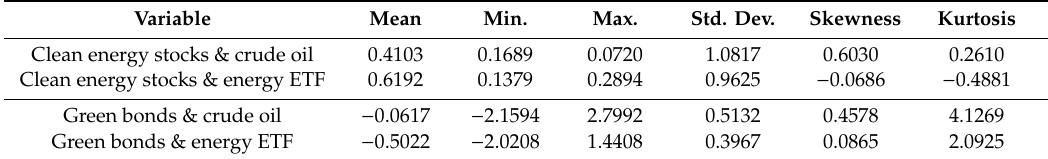
Table 3. Summary statistics of hedge